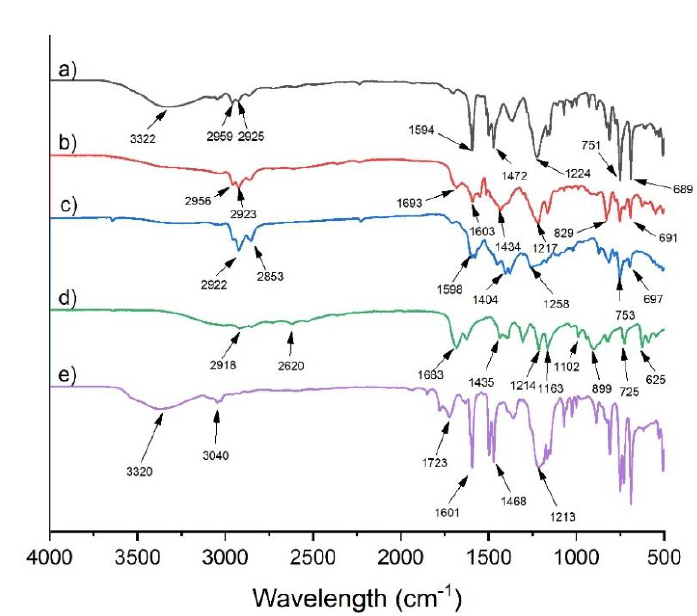
Fig. 1. FTIR spectrum of: a) the WPCB distillate; b) Solidified material 1; c) Solidified material 2; d) Solidified material 3; and e) Solidified material